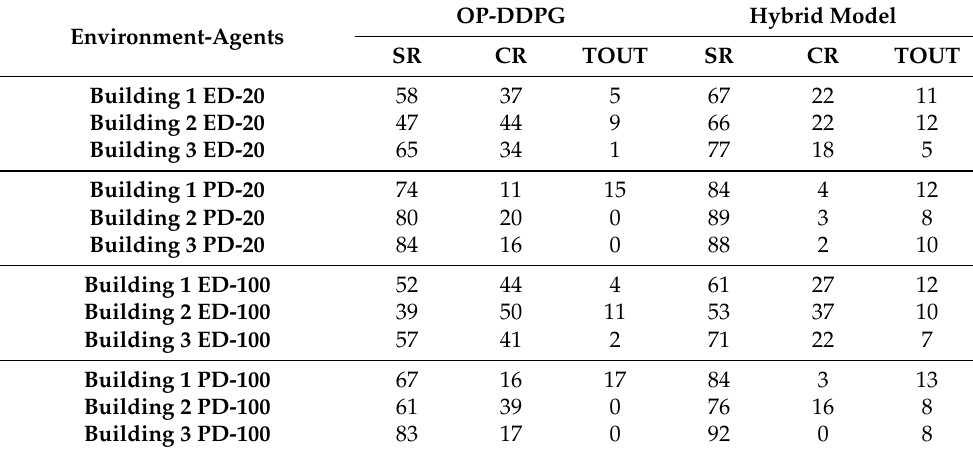
Table 2. OP-DDPG and Hybrid Model comparison for Euclidean and path distance cases in dynamic environments with 20 and 100 moving